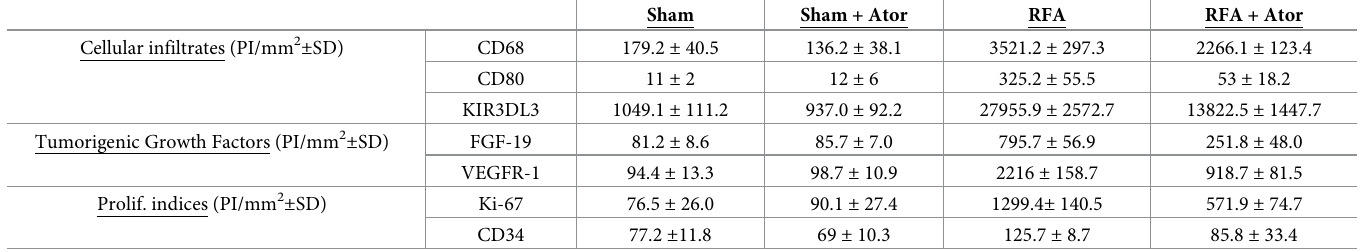
Table 2. Effect of myofibroblast blockade on cellular trafficking, downstream tumorigenic growth factors and proliferation in rat livers’ periablational rim collected 7 days post hepatic ablation. Sham Sham + Ator RFA RFA + Ator Cellular infiltrates (PI/mm 2 ±